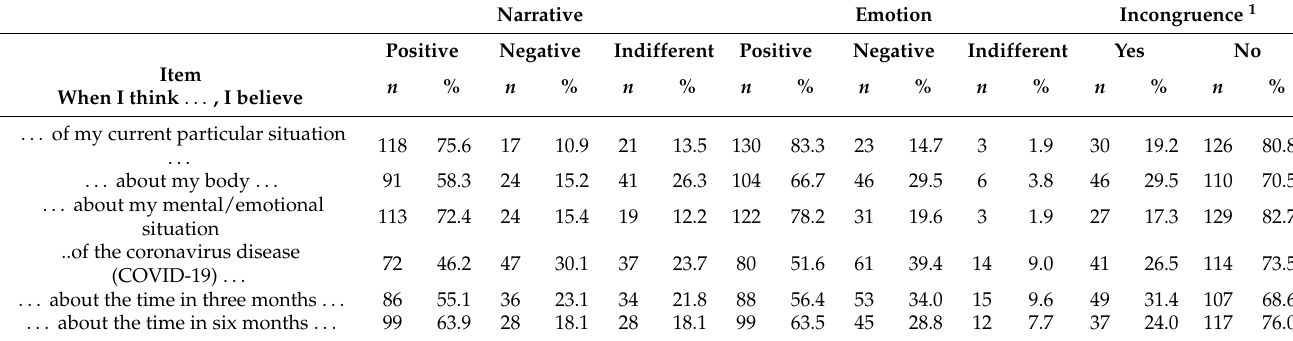
Table 2. Frequencies of the credition parameters across the items of the Believing Questionnaire. Narrative Emotion Incongruence 1 Positive Negative